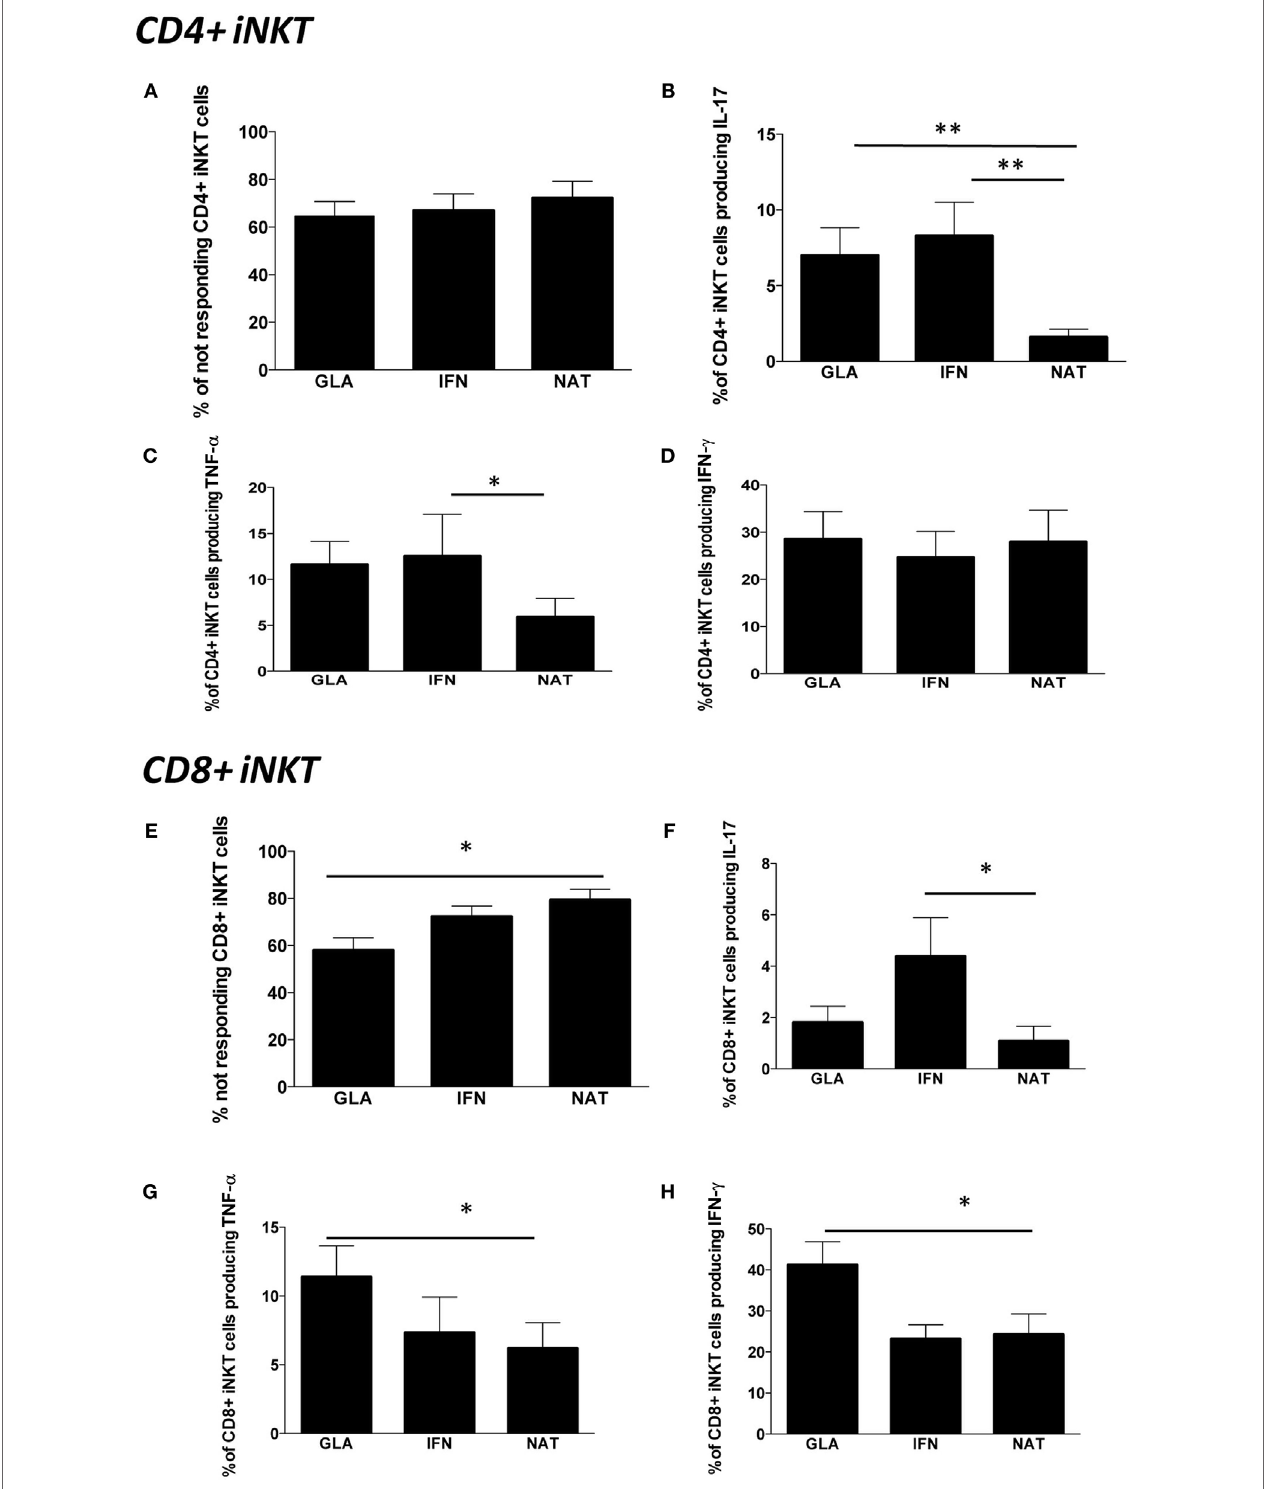
FigUre 5 | cytokine production by different subpopulations of inKT cells in rr patients treated with different immunomodulatory drugs